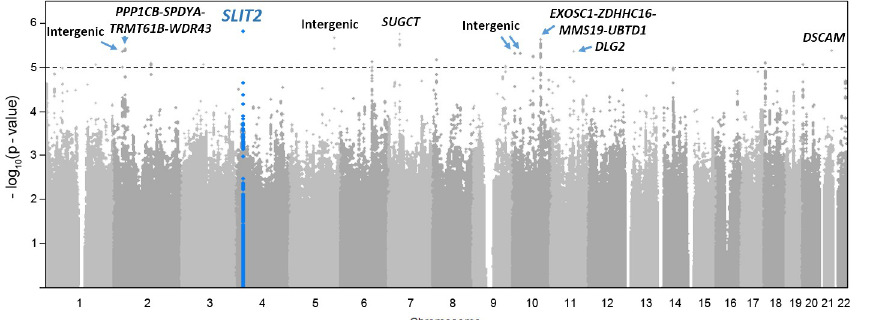
Fig 2. Manhattan plot of GWAS of SPTB. Each dot represents − log 10 ( p ) value of a single SNP in association analysis. Dashed line denotes level of suggestive significance ( − log 10 ( p ) > 5). SLIT2 , SUGCT , and EXOSC1-ZDHHC16-MMS19- UBTD1 were among the best associating